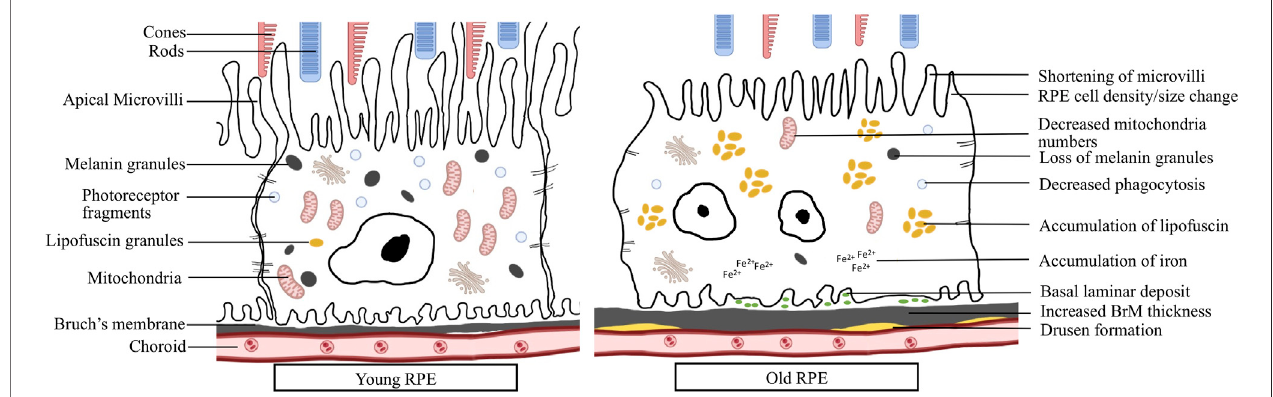
FIGURE 1 | RPE changes during aging: Young RPE cell shows elongated microvilli, tight contact with nearby cells, containing plenty of mitochondria, melanin granules and photoreceptor fragments. Aged RPE cell shows larger size, multinucleation, shortened microvilli, decreased mitochondria numbers, loss of melanin granules, decreased phagocytosis, accumulation of lipofuscin and iron, basal laminar deposits, increased BrM thickness and accumulation of drusen.